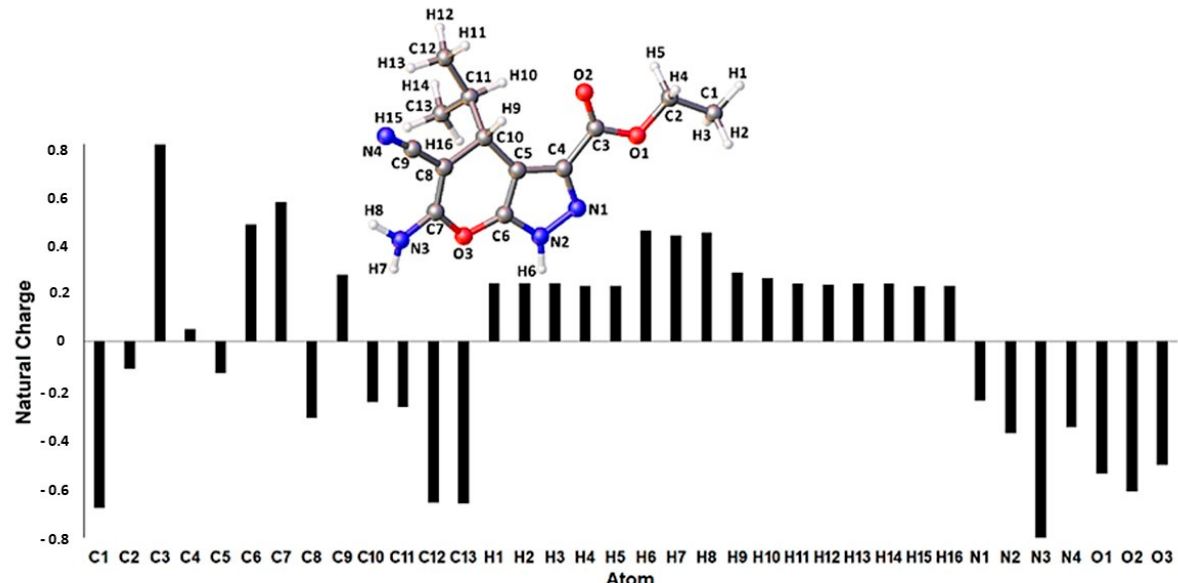
Figure 4. Natural population analysis distribution for the optimized 1d structure with the atoms labeled. Table 1. Antimalarial and cytotoxic activities of hybrid 4-aminoquinoline-pyrano[2,3-c]pyrazole derivatives.